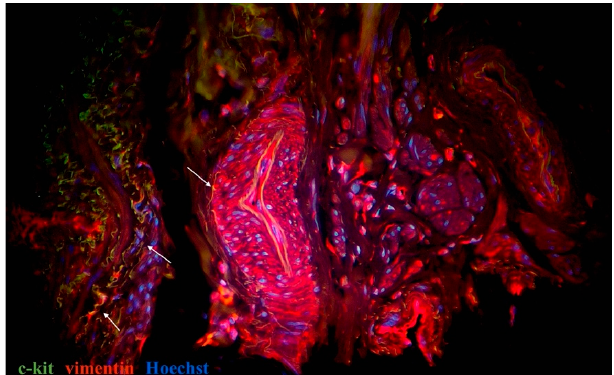
Figure 7. Tissue samples from human oviduct from control group stained for vimentin (red, Alexa Fluor 594) and c-kit (green, Alexa Fluor 488). Nuclei stained by Hoechst 33342. Doubly immunopositive cell with oval-shaped body and long cellular prolongation identified close to blood vessels and within tunica muscularis–oviductal telocytes (marked by arrows). Total magnification: ×400. 2.5. Expression of Oestrogen and Progesterone Receptors The expression of progesterone and oestrogen receptors in oviducts, the unchanged myometrium, the foci of the fibroid, and the adjacent myometrium were detected by im- munohistochemistry. All the types of observed tissue samples were positive for both sex steroid hormone receptors. Generally, the prevalence of expression was common for the mucosa of the oviduct; it has been rarely observed in the tunica muscularis. In patients with uterine myoma, the distribution of oestrogen and progesterone receptor expression in the oviduct was characterised by the declining expression of oestrogen receptors and rising progesterone receptors (significantly higher than in the control). The same tendency was common for the foci of myomas. The expression of oestrogen receptors was lower in the foci of fibrosis (within myomas) than in the unchanged myometrium from the control group. Myometrial tissue, located close to a myoma capsule (adjacent myometrium), was characterised by the poor expression of sex steroid receptors (compared to the foci of my- oma and unchanged myometrium). The oviductal tissue from the control group had fewer progesterone receptors and more oestrogen receptors. By comparing the expression in both groups, we note that the control group was characterised by a prevalence of oestro- gen receptors. However, the patients with uterine myoma had two common tendencies concerning its expression: increasing progesterone receptor expression and declining oes- trogen receptors (compared to control). The unchanged myometrium (“healthy”) has more oestrogen receptors than all the observed samples from the study group (myoma and adjacent myometrium). In our study, we reveal that, in the study group, the pattern of sex steroid receptors retained the expression in the fibroid foci. We emphasise that no pathological changes were revealed in the oviductal tissue from the study group. The tu- bal and uterine telocytes were positive for both nuclear steroid receptors and were re- vealed in all observed tissue samples. 2.6. Biochemical Parameters Both groups showed no difference in the FSH and LH blood levels, while the oestra- diol and progesterone levels depended on the presence of uterine myoma. Patients with uterine myoma had higher levels of progesterone in the blood. Oestradiol was higher in the control group (Table 2). These data correlate with an expression of sex steroid hor- mones in the tissue samples. The level of AMH was lower in patients with uterine myoma. No significant differences in the blood levels of soluble VEGFR1 (sflt) were revealed in